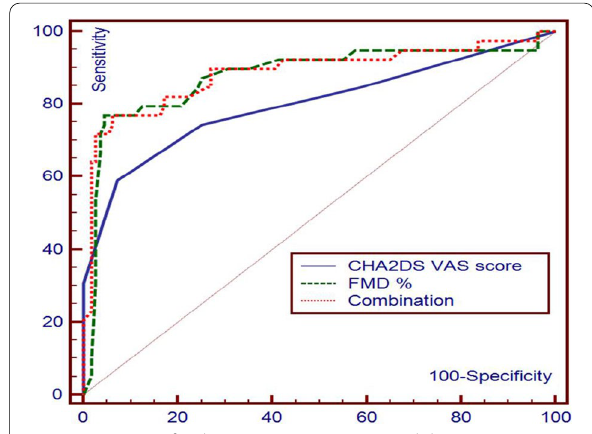
Fig. 1 ROC curve for the CHA2DS VASc score and the FMD percentage